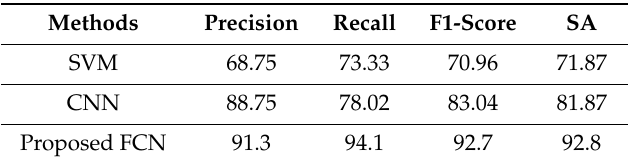
Table 2. A comparison of the support vector machine (SVM), convolutional neural network (CNN), and the proposed FCN model.